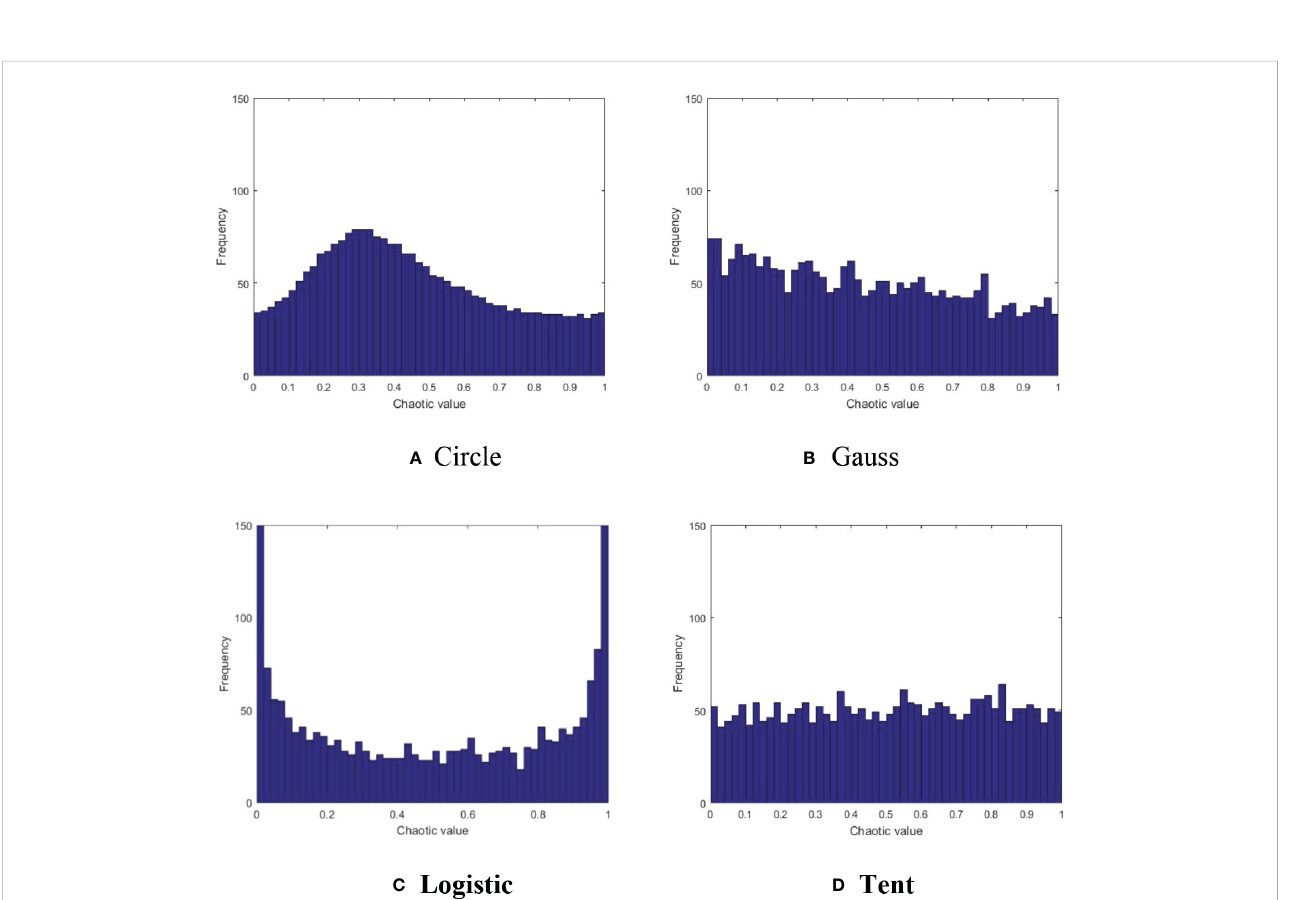
FIGURE 1 Comparison of four chaotic maps. (A) Circle (B) Gauss (C) Logistic (D)